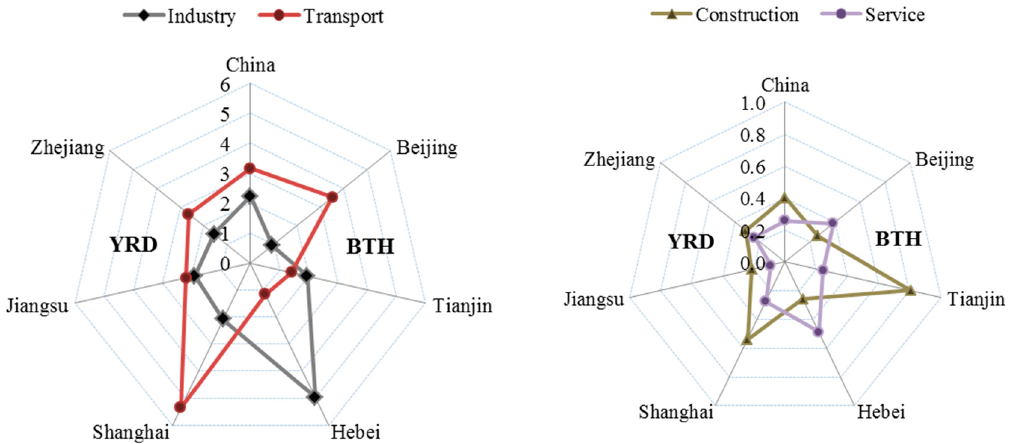
Figure 2. Energy intensity (MJ/RMB) of study regions and China in 2015 by sector (data source: China Energy Statistical Yearbook 2016 and China Statistical Yearbook 2016).